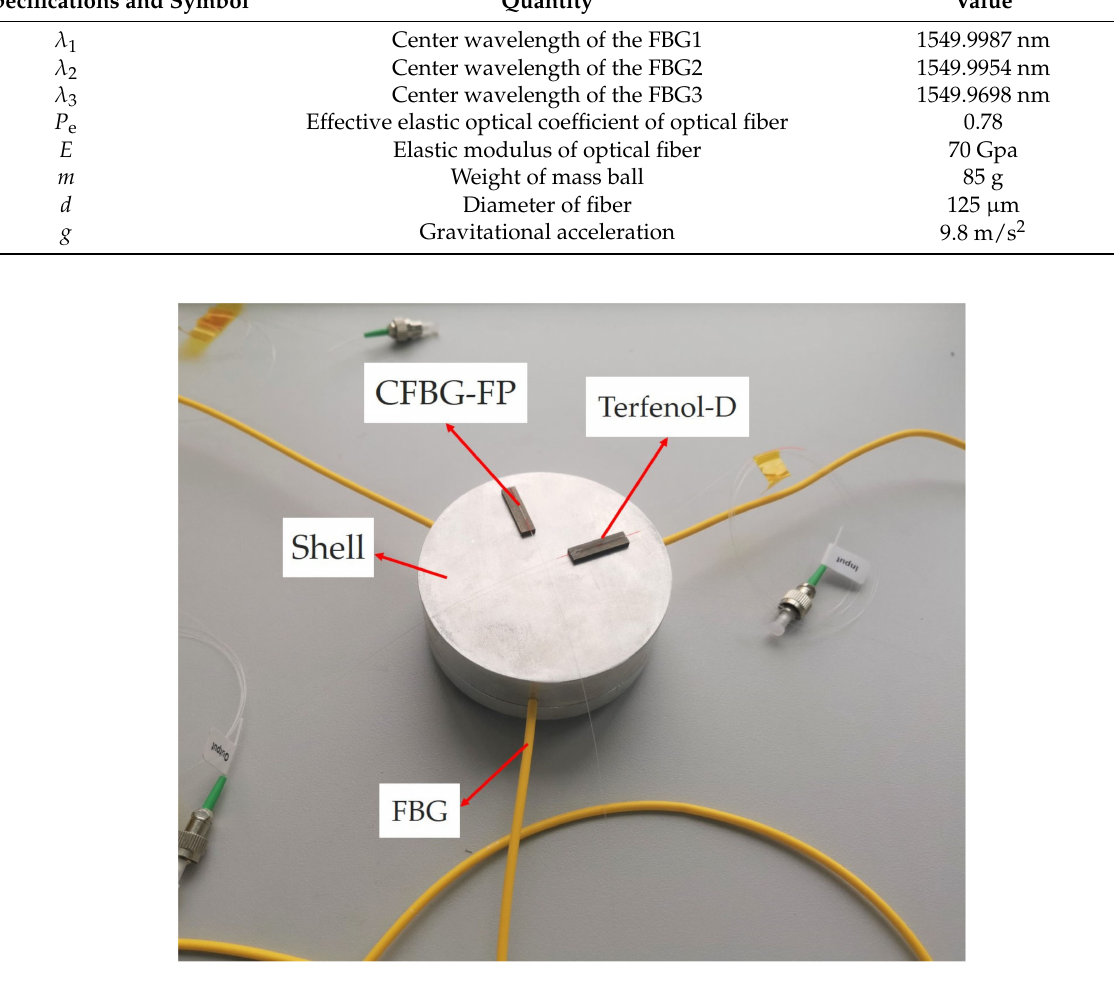
Figure 2. Experimental sensing unit of all-fiber optical sensor combined with FBG and